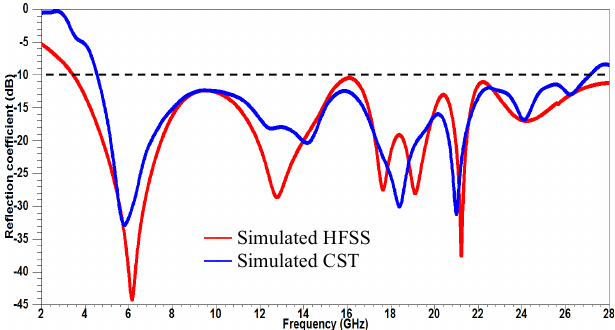
Figure 9: Simulated reflection coefficient of proposed DRA The simulated radiation patterns in the E( yz )-plane and H( xz )-plane at four different frequencies (5, 10, 16, and